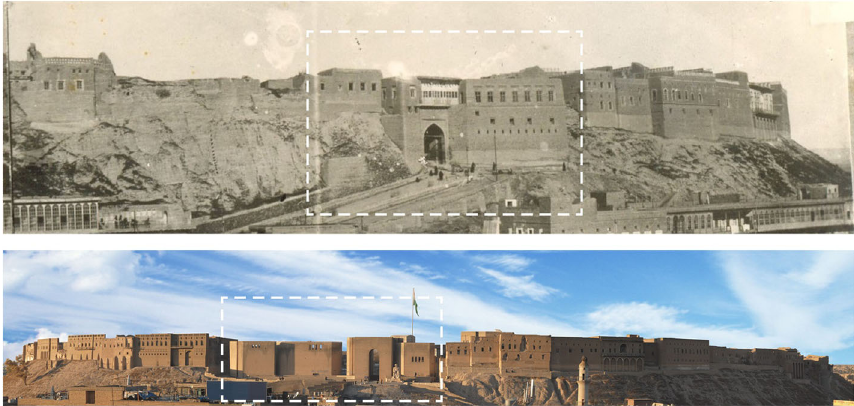
Fig. 4 Above: the original gate of the Citadel after 1930s (Source: HCECR 2012a, 2). Below: the ‘ BG ’ of the Citadel after 1970s, displays a new architectural structure as a segmented-abstract linear barrier (Source: site archival